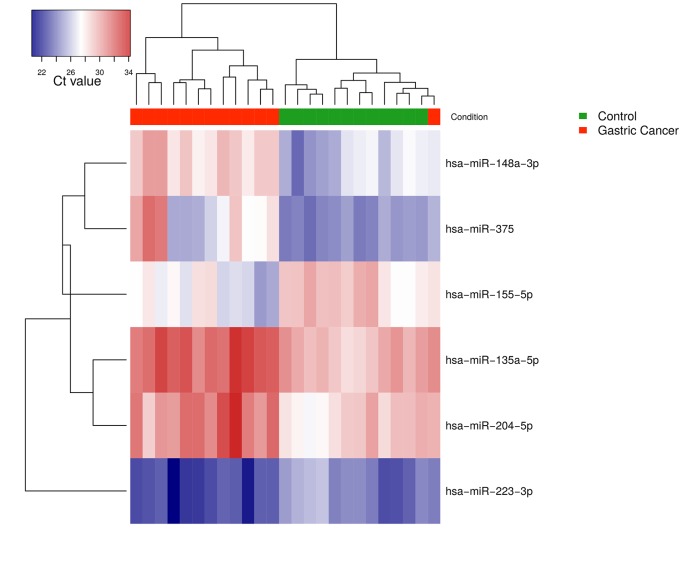
Heat-map diagram of a two-way hierarchical clustering analysis consisting of the 6 most differentially expressed miRNAs in GC tissue and normal gastric mucosa.The red and blue colors indicate expression level of miRNAs in terms of normalized Ct value. Upper color labeling shows GC patient samples in red and controls in green. Distance of hierarchical clustering was measured using the Euclidean method.